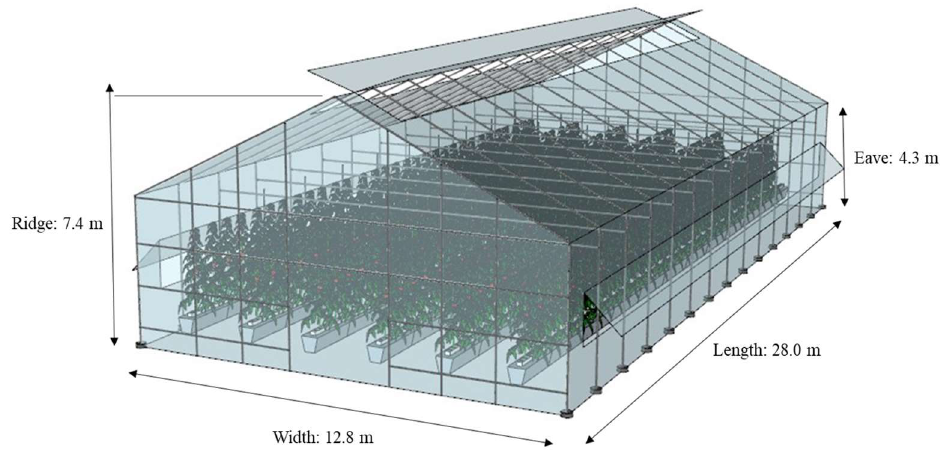
Figure 4. Wide-span greenhouse hypothetically installed on the roof of the experimental building.